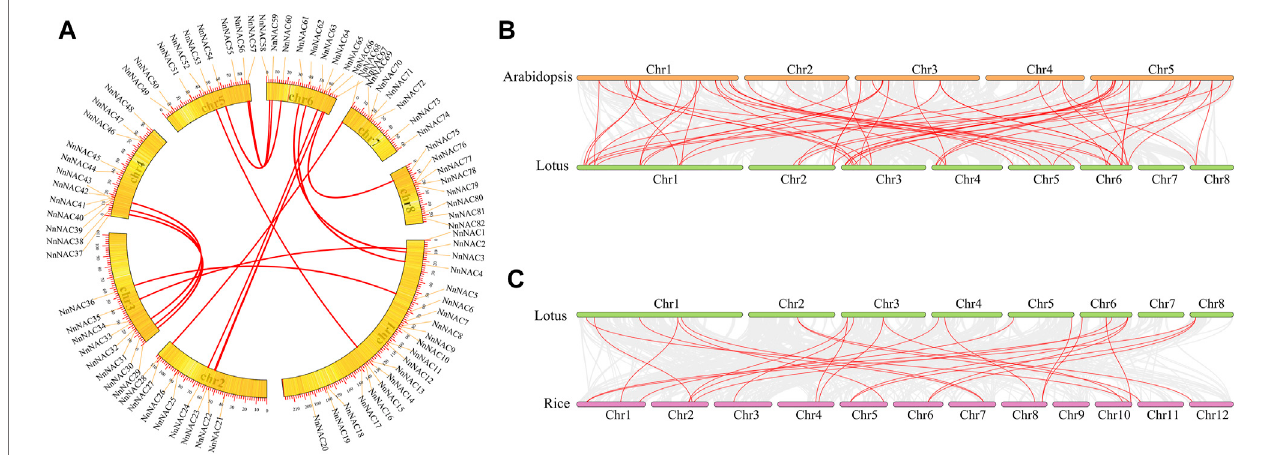
FIGURE3| Genomescalesyntenyanalysisoflotus, Arabidopsis ,andrice NAC genes. (A) Syntenicrelationshipof NnNAC genes.All82 NnNAC genesaremarked according to their chromosome distribution in the lotus genome and syntenic gene pairs are connected with red lines. (B) Syntenic pairs of NAC genes between Arabidopsis and lotus. (C) Syntenic pairs of NAC genes between lotus and rice. The lotus, Arabidopsis , and rice chromosomes are shown in orange, green, and purple bars, respectively. Syntenic gene pairs are linked with red